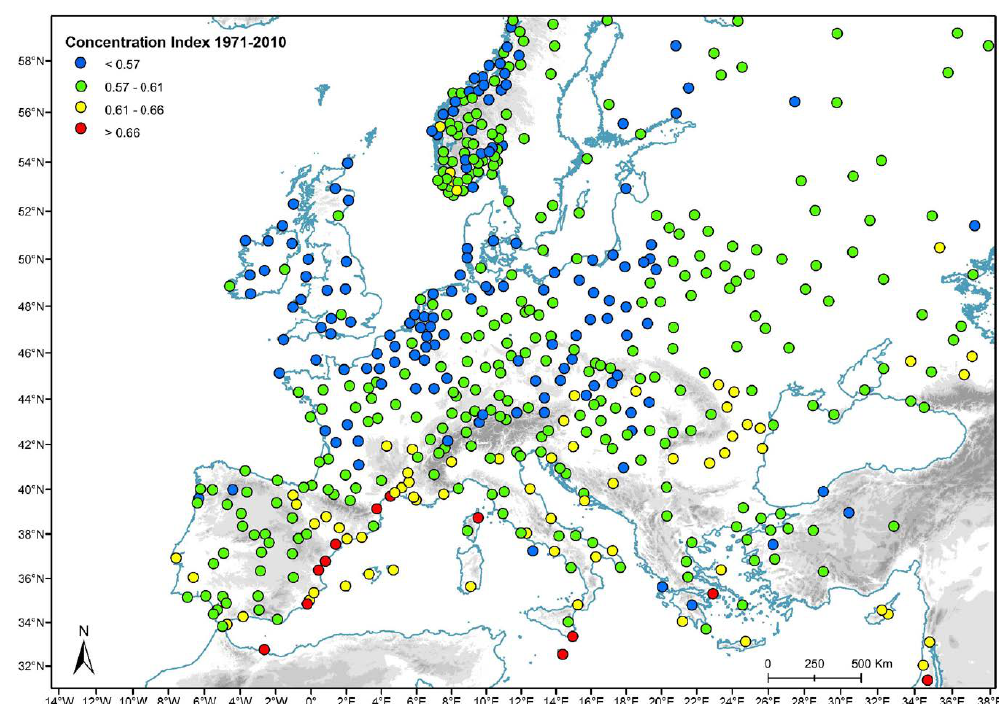
Fig. 5. Spring CI values distribution. Each colour corresponds to a different interval: CI values 0.56 or lower (blue dots), between 0.57 and 0.61 (green dots), between 0.62 and 0.66 (yellow dots), and 0.67 or higher (red dots).